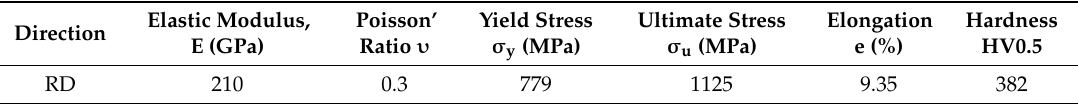
Table 2. Basic mechanical properties of the studied DP1000 (RD: Rolling direction).